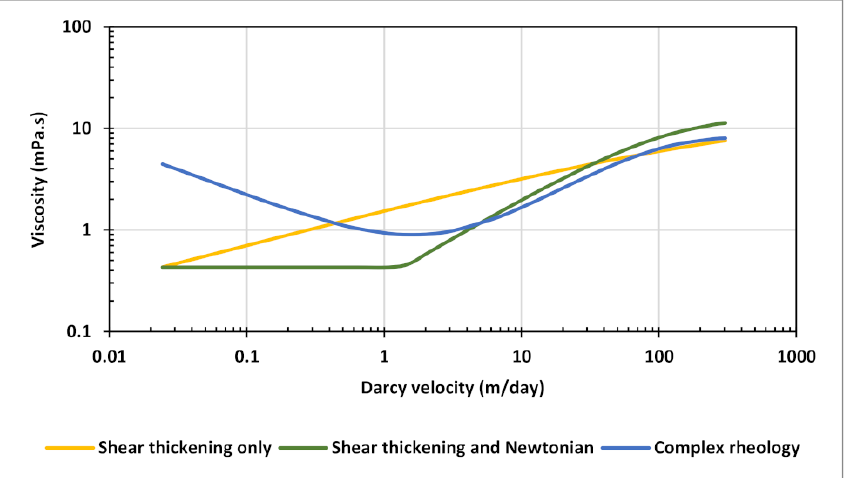
Figure 20. Shear thickening rheology scenarios tested for polymer injection history matching.